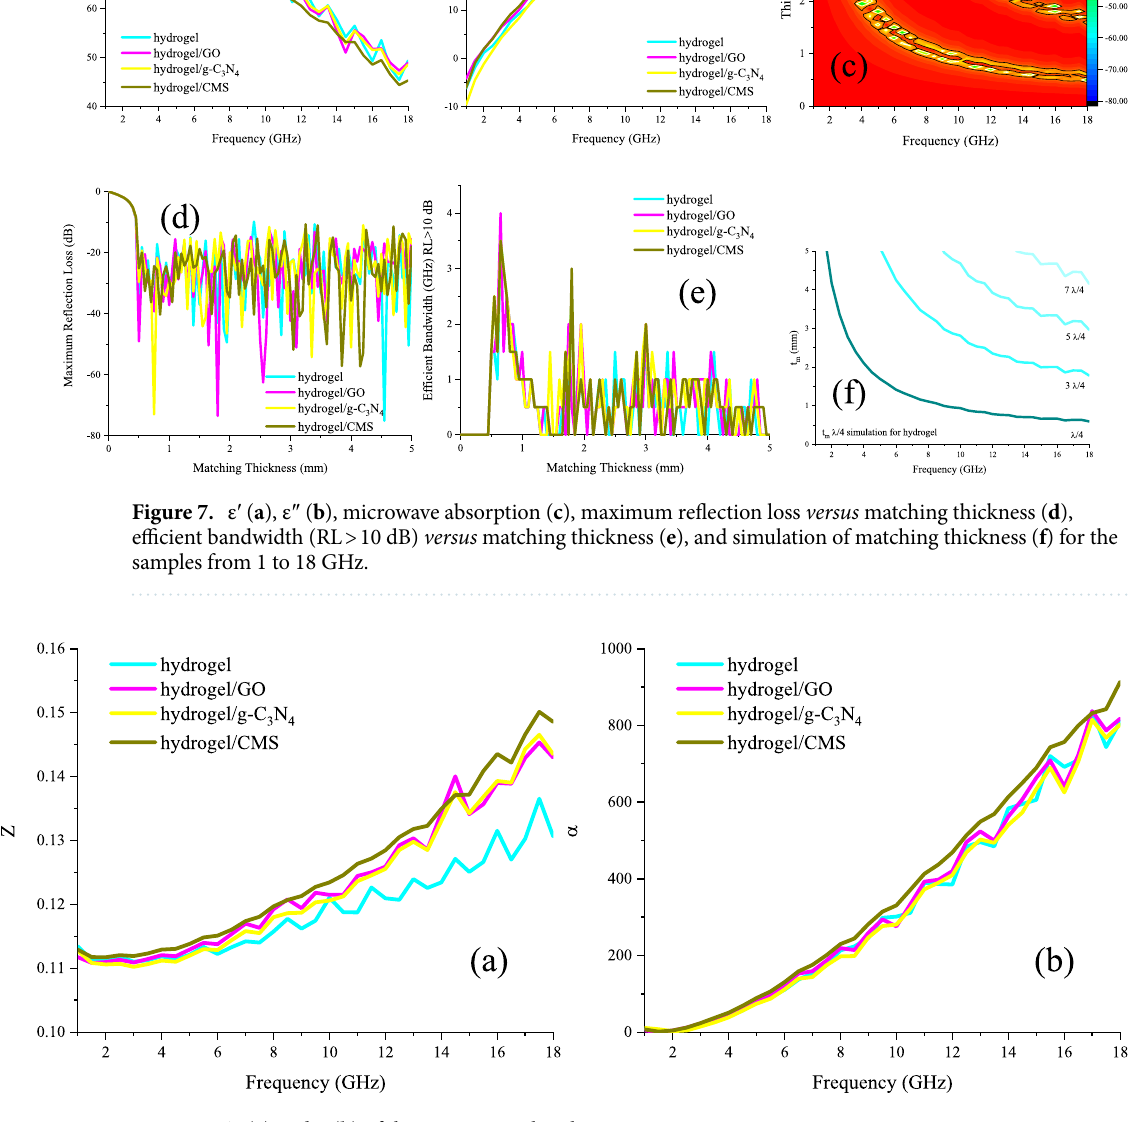
Figure 8. Z ( a ) and α ( b ) of the microwave absorbing